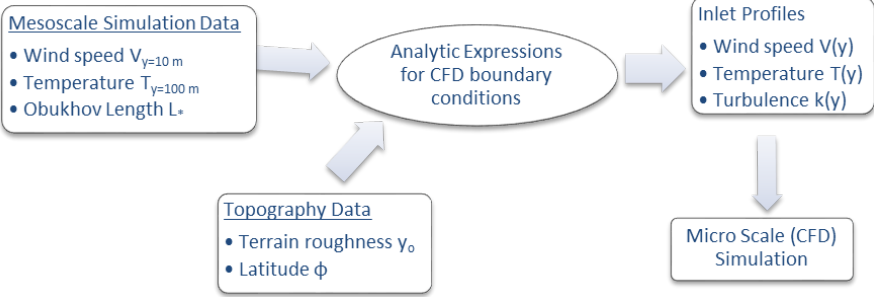
Figure 3. Flow chart of data for derivation of vertical profiles of wind speed, temperature and turbulence kinetic energy, necessary as boundary condition for CFD microscale simulation.